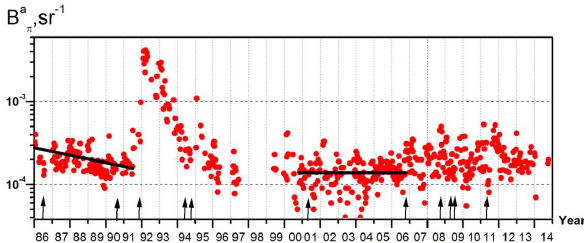
Figure 12. Time variations in the integral aerosol backscattering coefficient at a sensing wavelength of 532nm in the altitude range